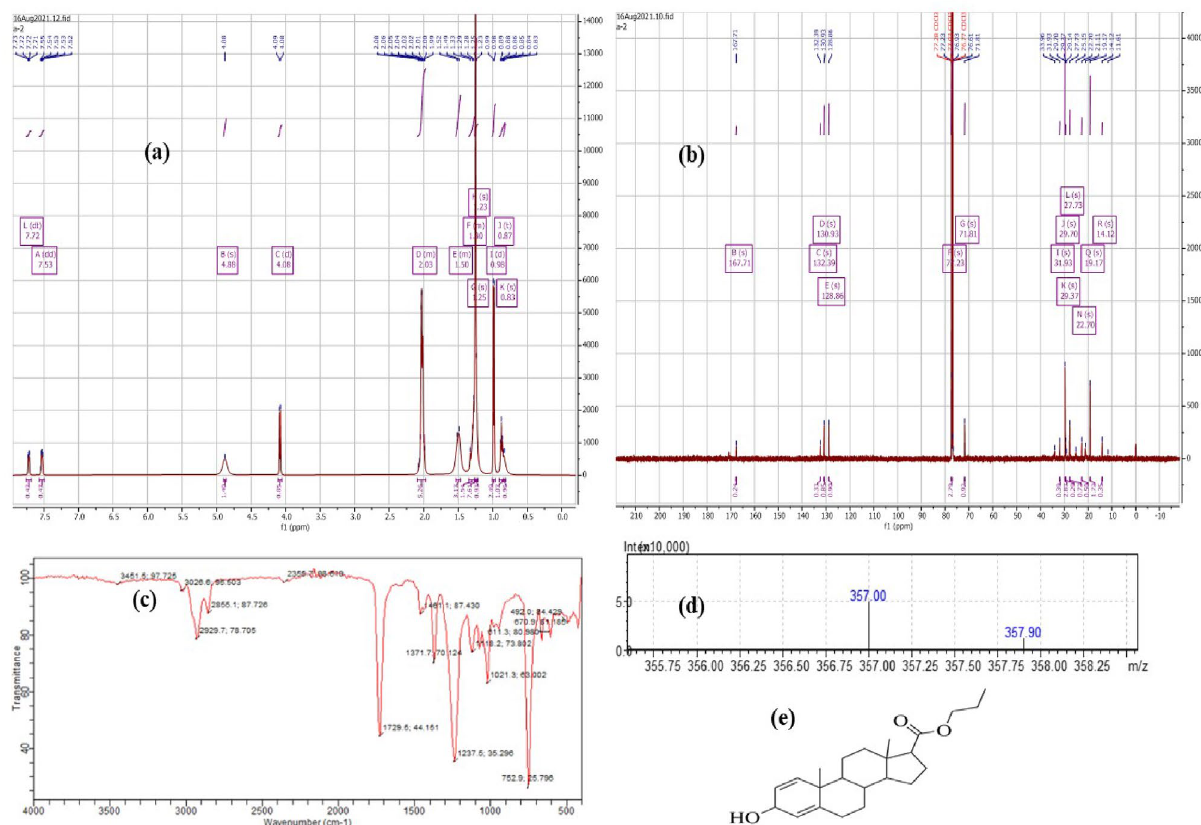
Figure 1. ( a ) 1 H NMR spectra; ( b ) 13 C NMR spectra; ( c ) FTIR spectra; ( d ) LCMS data; ( e ) Structure of